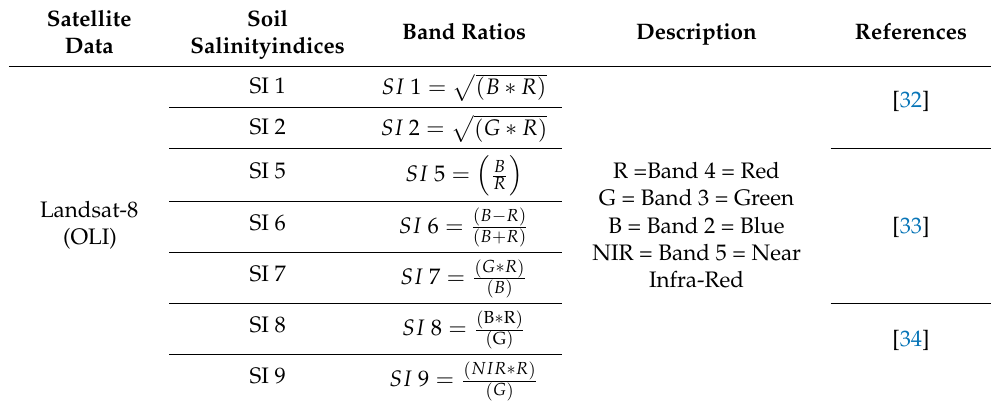
Table 2. Soil salinity indices description based on different spectrum band ratios of Landsat-8 (OLI).